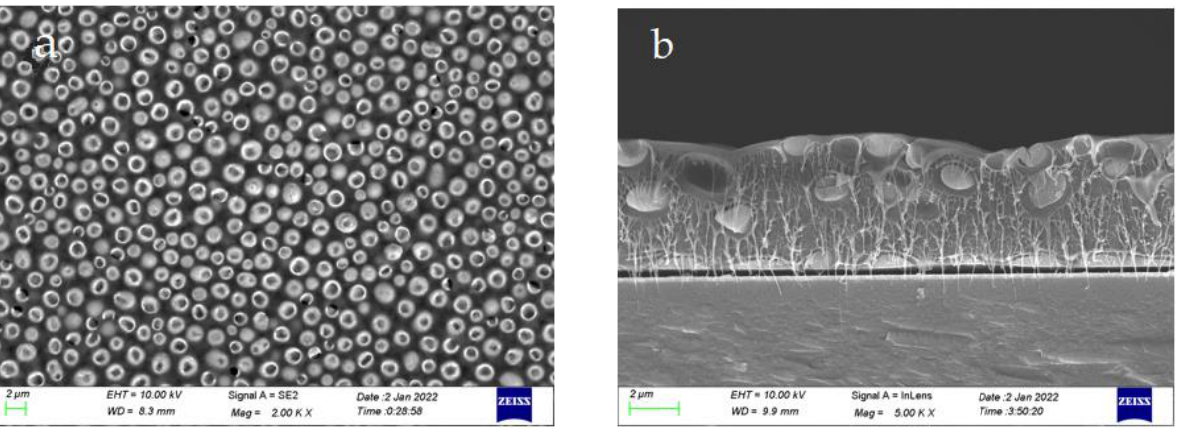
Figure 4. The 0-3 type piezoelectric film morphology at 500 – 1000rpm speed (( a , b ) annealing temperature 90 °C, 20,000× top view, 50,000× cross-sectional view).